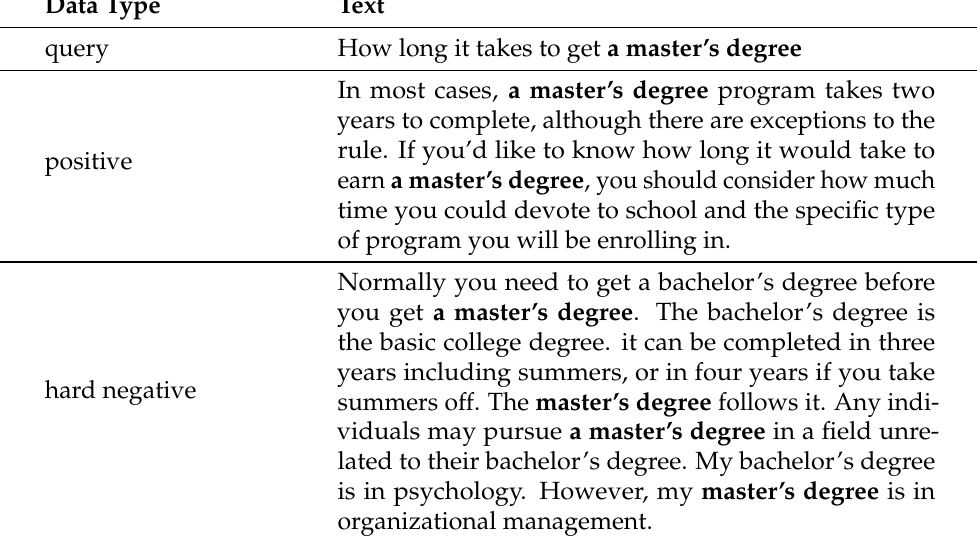
Table 1. Hard Negative Case. In this case, the keywords ‘a master’s degree’ are mentioned many times both in the positive and the negative. The cosine similarity of the positive and the hard negative is 0.9, which is calculated as shown in Section 4.2. This kind of negative is called hard negative; however, a hard negative is always regarded as a common negative, since it is too expensive to label all